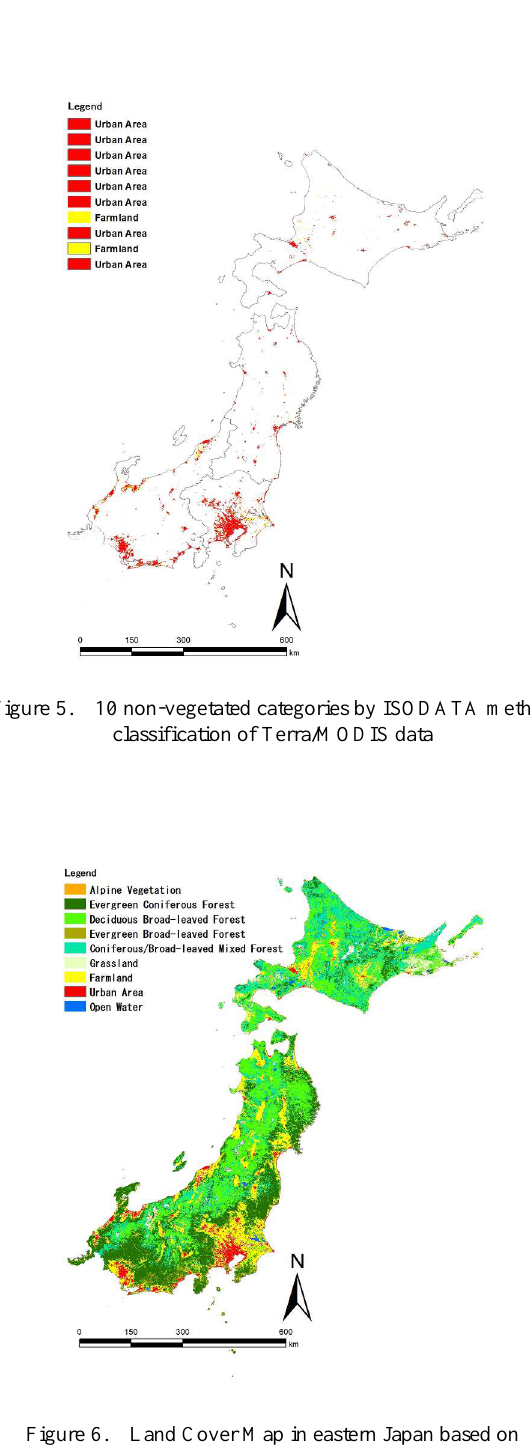
Figure 6. Land Cover Map in eastern Japan based on Terra/MODIS data for